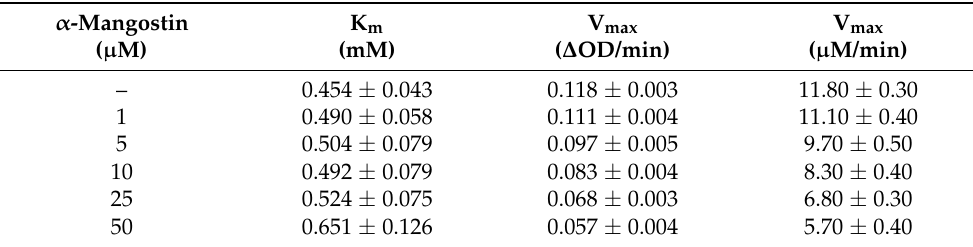
Table 1. K m and V max values of 0.05 µ M α -glucosidase with different concentrations of α -mangostin using 2 mM pNPG as